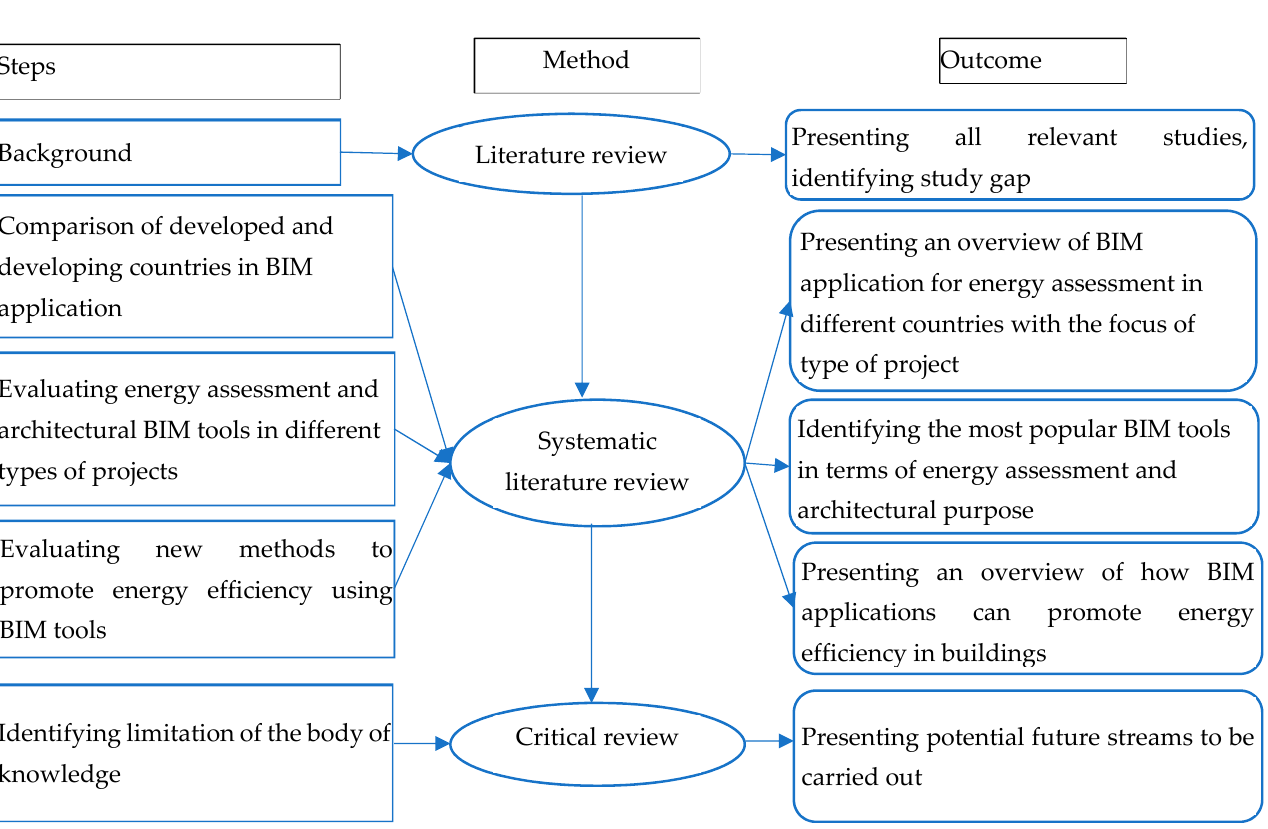
Figure 1. Methodological framework.